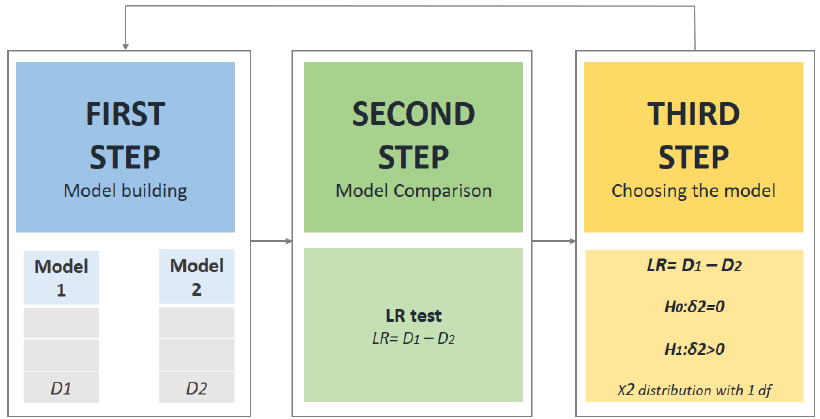
Figure 2. Three-step model building methodology.